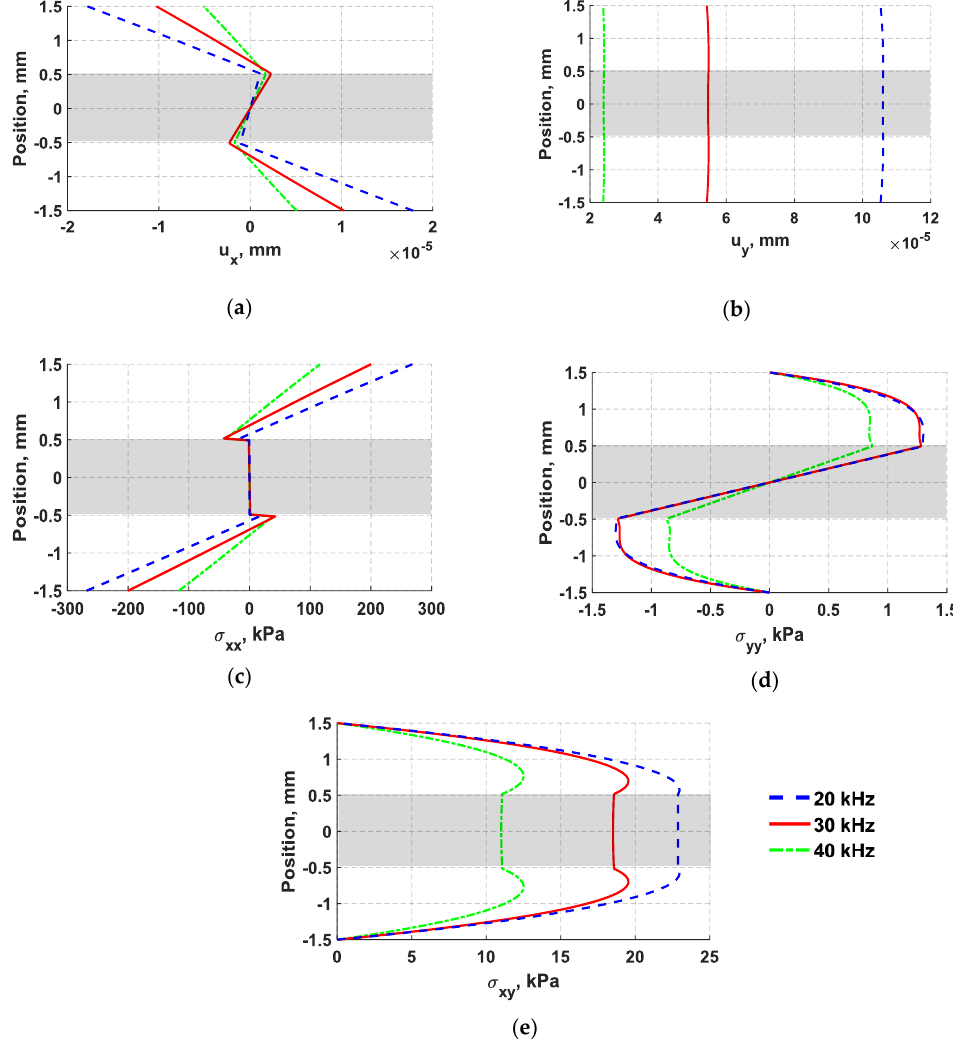
Figure 10. Comparison of through thickness displacements and in-plane stresses of flexural waves induced by bondline-embedded d35 actuated with 5-peak Hanning window signal at three actuation frequencies: 20 kHz (blue dashed line), 30 kHz (red solid line), and 40 kHz (green dash-dotted line). ( a ) axial (x) displacement; ( b ) lateral (y) displacement; ( c ) stress in x-direction; ( d ) stress in y-direction; ( e ) in-plane shear stress.